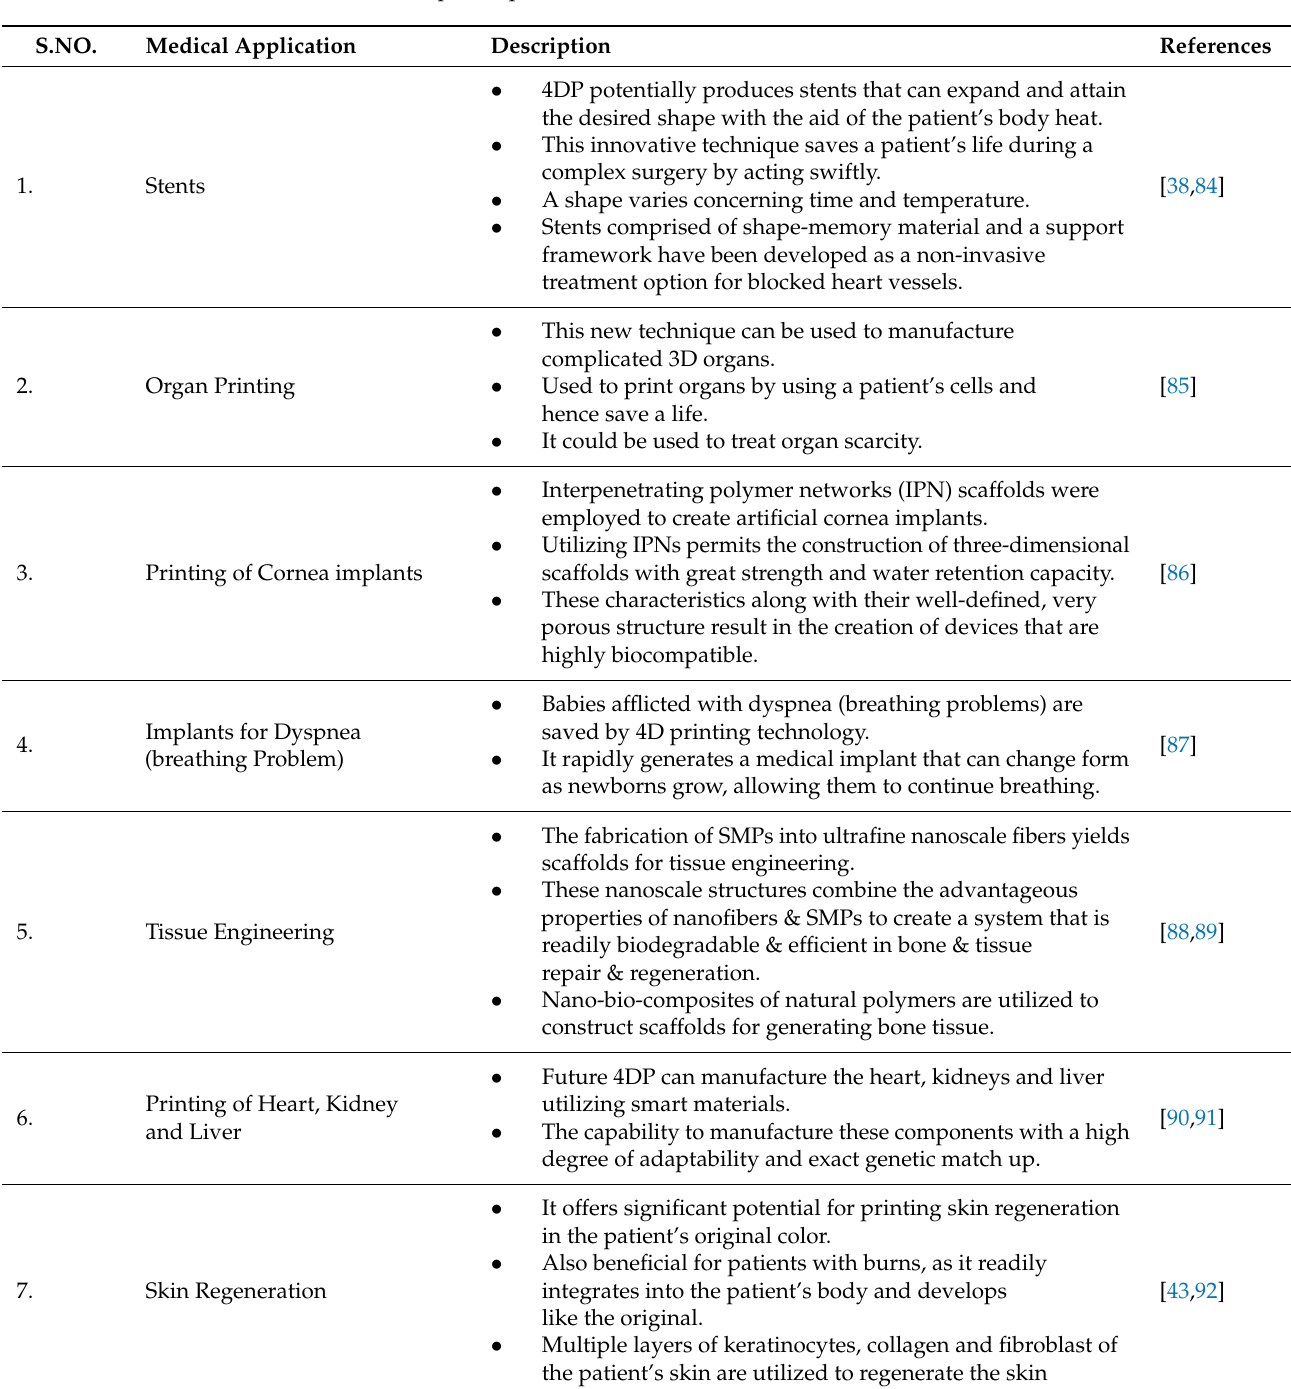
Table 3. Application of 4D printing in health care. This includes 4D Printing of various vital organs such as kidney, bones and heart valve. For manufacturing of dosage forms such as tablets, using 4DP will scale up their